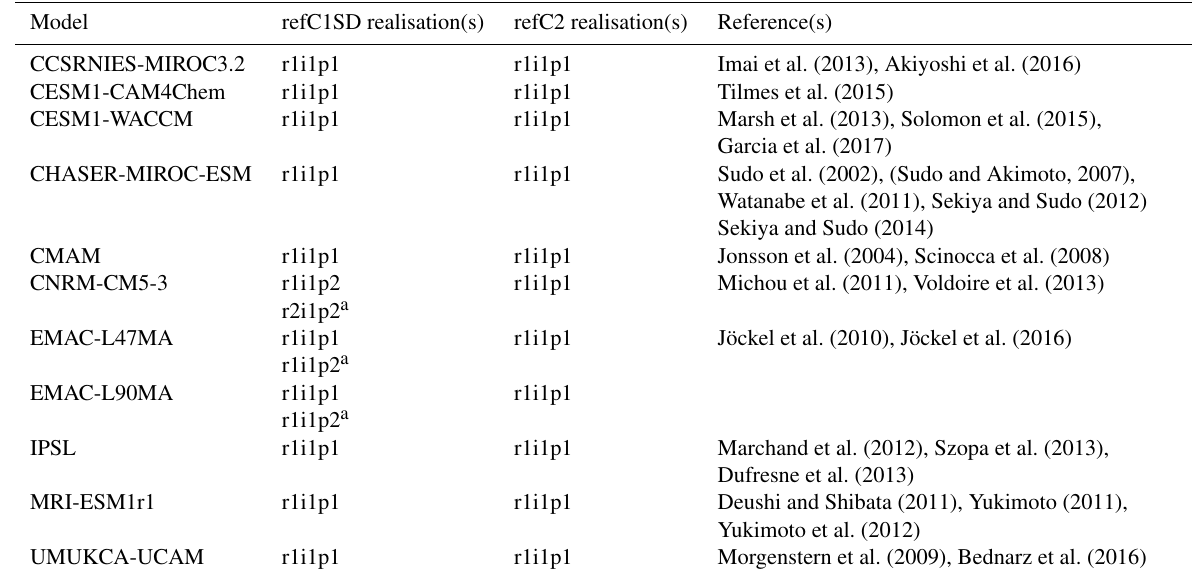
Table 1. The CCMI model simulations used in this analysis and their key references.